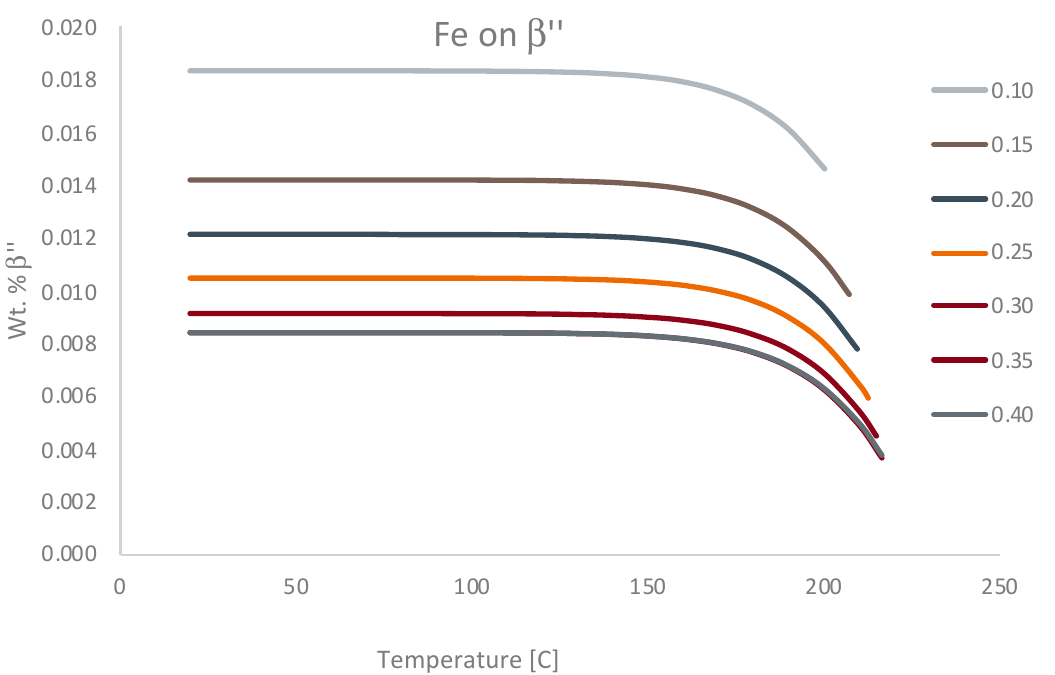
Figure 15. Phase fractions of β″ phase as a function of varying iron content over a range of temperatures.